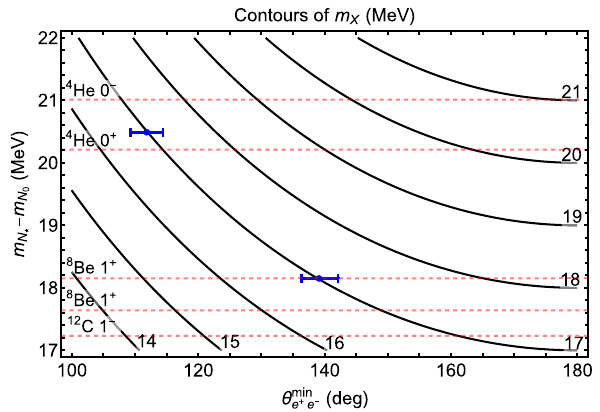
Fig. 31 Contours (black solid lines) of the X boson mass m X in the and the nuclear state mass plane of the minimum opening angle θ min e + e − splitting m N ∗ − m N . Particularly relevant mass splittings are indicated 0 by red dashed lines. The blue points and error bars indicate the parame- ters where 7 σ excesses have been found in 8 Be and 4 He nuclear decays. As can be seen, the excesses are at different opening angles θ min , but e + e − both are consistent with the production of a 17 MeV X boson. From Ref.